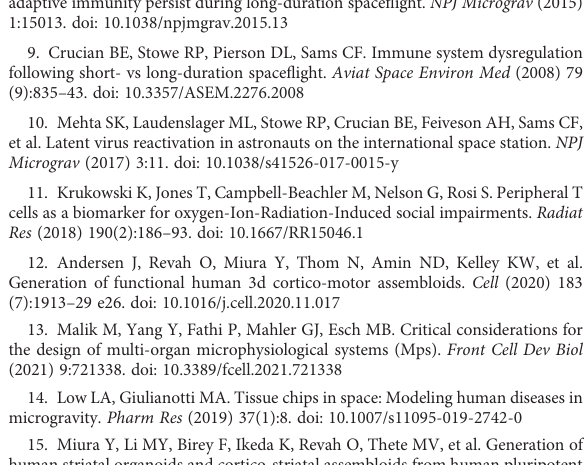
SUPPLEMENTARY FIGURE 2 Vascular endothelial responses to SimGCRSim irradiation. (A – D). Quanti fi cation of endothelial ZO1 (A, B) and PECAM1 (C, D) immuno fl uorescence 1 day after irradiation. (E – H). Quanti fi cation of endothelial ZO1 (E, F) and PECAM1 (G, H) immuno fl uorescence 7 days after irradiation. Open bars, chips with endothelial cells only. Shaded bars, chips with endothelial cells and astrocytes. Blue, 0 Gy sham irradiation. Light red, lower dose (0.25 Gy). Dark red, higher dose (0.5 Gy). N = 12 areas from 6 chips per condition. Error bars, mean ± SEM. *p < 0.05, **p < 0.01, ***p < 0.001, ****p < 0.0001, 1-way ANOVA, Dunnett ’ s multiple comparisons test. Non statistically signi fi cant changes are not marked. SUPPLEMENTARY FIGURE 3 Ionizing radiation causes oxidative stress in endothelial cells and astrocytes. Secreted 8-oxo-dG 3 days post irradiation with 600 MeV/n 56 Fe particles, cells cultured in 6-well plates instead of OrganoPlates. Open bars, endothelial cells. Shaded bars, astrocytes. N = 6 chips/ condition. Blue, 0 Gy sham irradiation. Light red, lower dose (0.3 Gy). Dark red, higher dose (0.82 Gy). Error bars, mean ± SEM. **p < 0.01, 1-way ANOVA. Non statistically signi fi cant changes are not marked. SUPPLEMENTARY FIGURE 4 Ionizing radiation affects astrocytic cytokine and chemokine secretion and causes cellular damage. (A – E) , quanti fi cation of key in fl ammatory cytokines and chemokines: IL-1ra (A) , Eotaxin (B) , MCP-1 (C) , IP-10 (D) and FGF2 (E) secreted by astrocytes cultured in OrganoPlates, 3 days after irradiation with 600 MeV/n 56 Fe particles. Blue, 0 Gy sham irradiation. Pink, lower dose (0.3 Gy). Dark red, higher dose (0.82 Gy). N = 5-6 chips per condition. Error bars, mean ± SEM. *p < 0.05, **p < 0.01, Kruskal- Wallis test with Dunn ’ s correction for multiple comparisons. Non statistically signi fi cant changes are not marked. F. Representative bright fi eld images of astrocytes cultured in regular 6-well plates, 3 days after irradiation with 600 MeV/n 56 Fe particles. Scale bar, 100 m